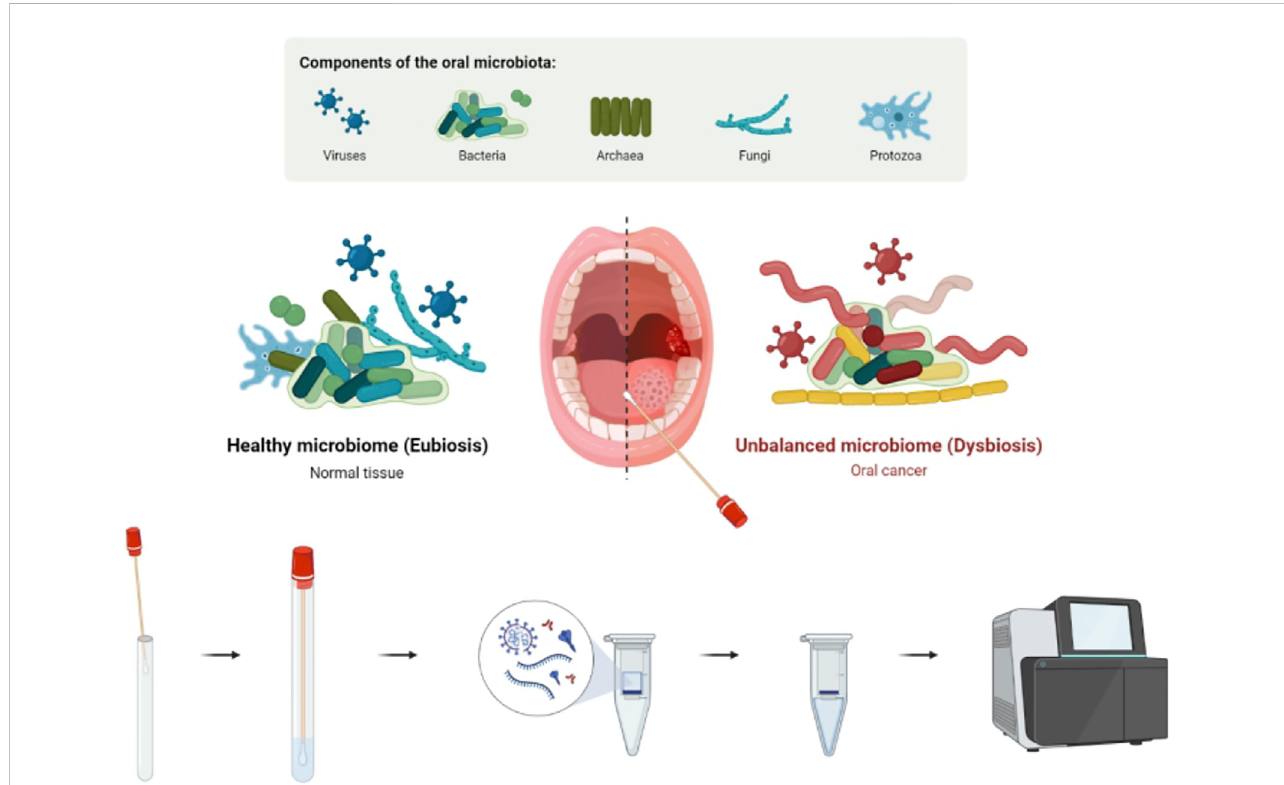
FIGURE 1 Existence and manifestation of the oral microbiota in OSCC. Intratumor oral microbiota of tumor/normal tissue was obtained through an oral swab. Microbial abundance was determined by high-throughput sequencing, and early diagnosis and prognosis prediction of OSCC were